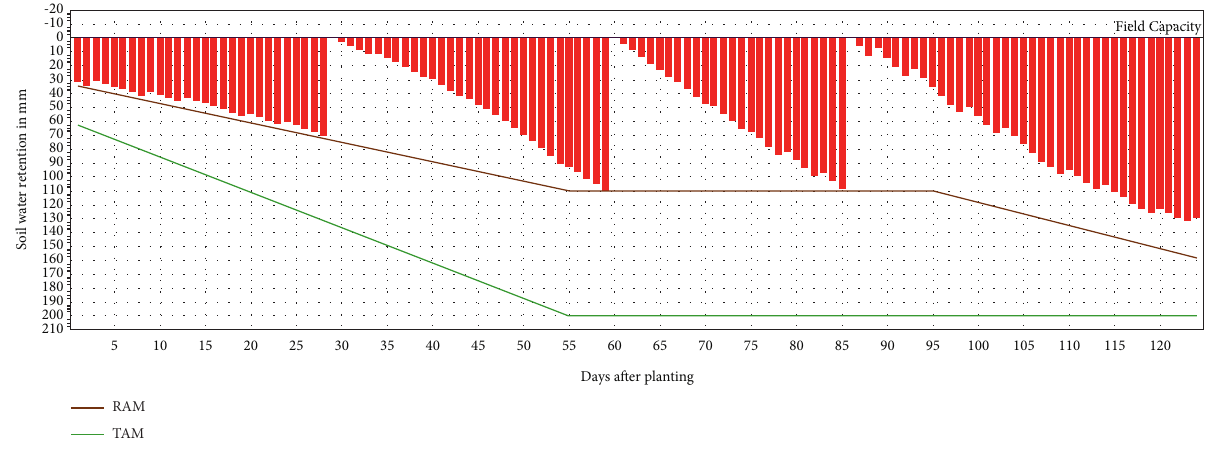
Figure 5: Color reveals the citrus irrigation schedules showing RAM (brown line); TAM (green line); and water depletion (red vertical line pattern).